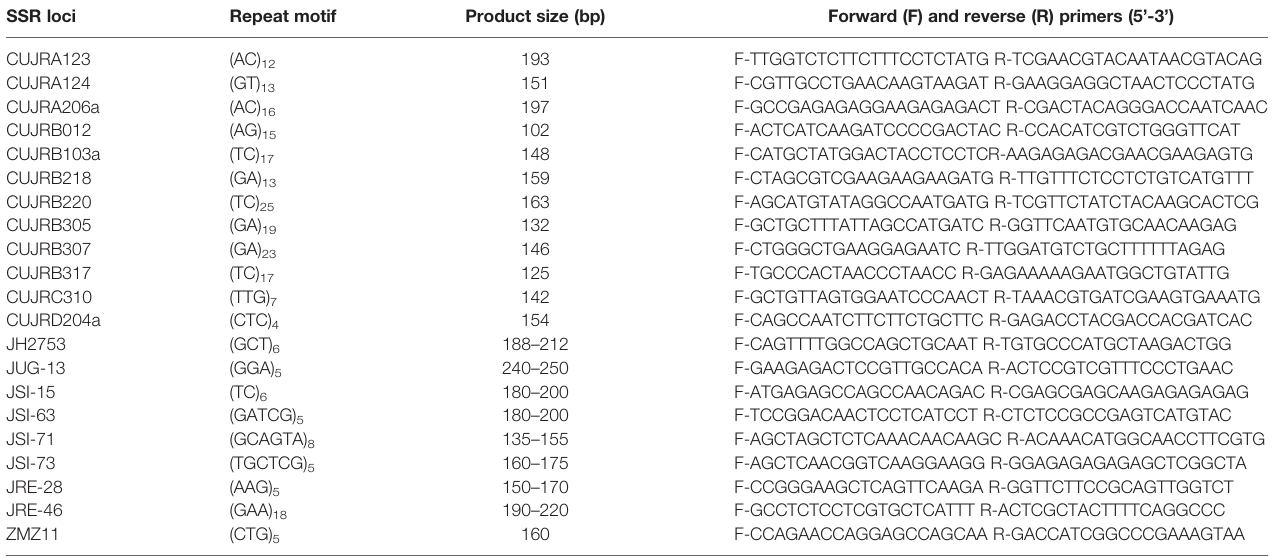
TABLE 2 | The 21 SSR loci distinguish Sichuan walnut materials used in this